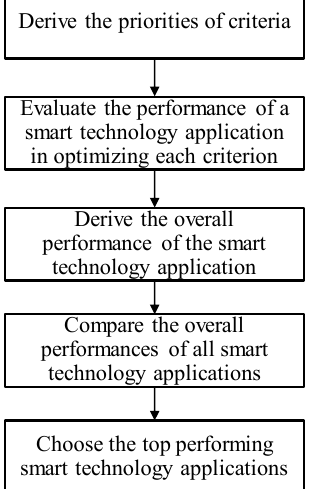
Figure 2. Procedure for the CFGM-FTOPSIS approach.